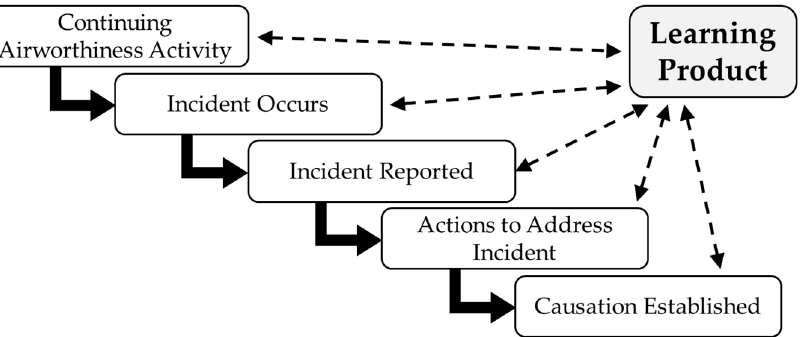
Figure 1. Incident learning product and process (Broken line denotes iterative learning feedback).